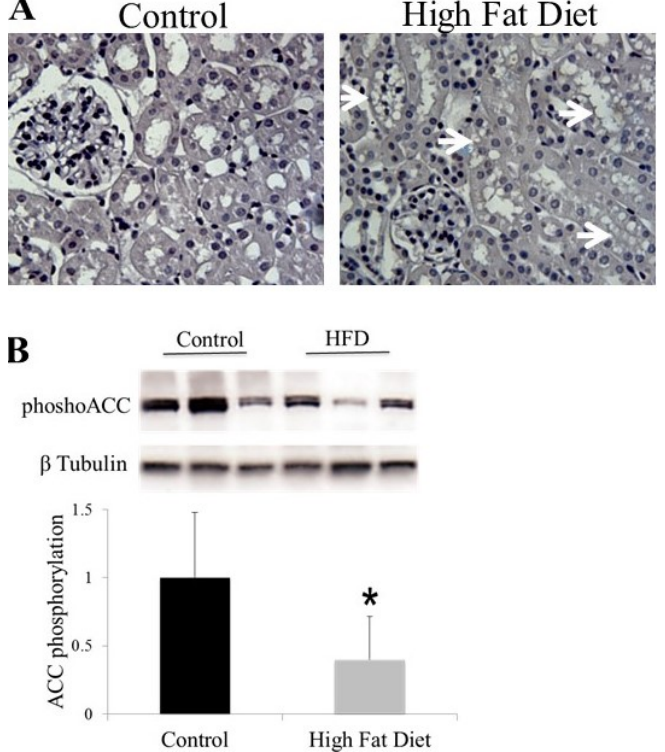
Figure 1. ( A ) C57Bl/6 mice were fed a high fat diet (23% fat by weight) or control diet (5% fat by weight) for 14 weeks. Kidney sections (4 µM) were counterstained with haematoxylin and assessed morphologically. Mice fed a high fat diet developed lipid vacuoles localised to proximal tubular epithelium; ( B ) Reduced ACC phosphorylation (S79/S212) in the renal cortex of mice fed a high fat diet for 14 weeks. Cortical tissue was homogenised and then ACC phosphorylation (S79/S212) was analysed by Western blot with a